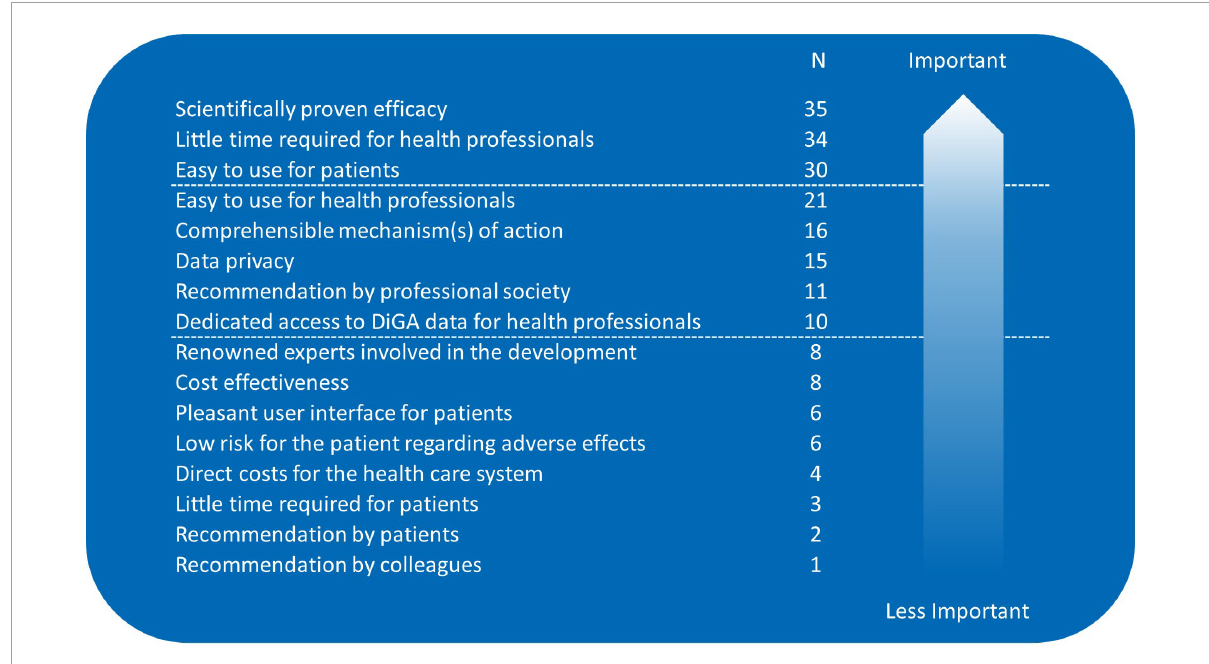
FIGURE1 Aspects relevant for digital health application (DiGA) prescriptions; sorted by importance/number of mentions (participants needed to pick their three most relevant aspects from a pre-given